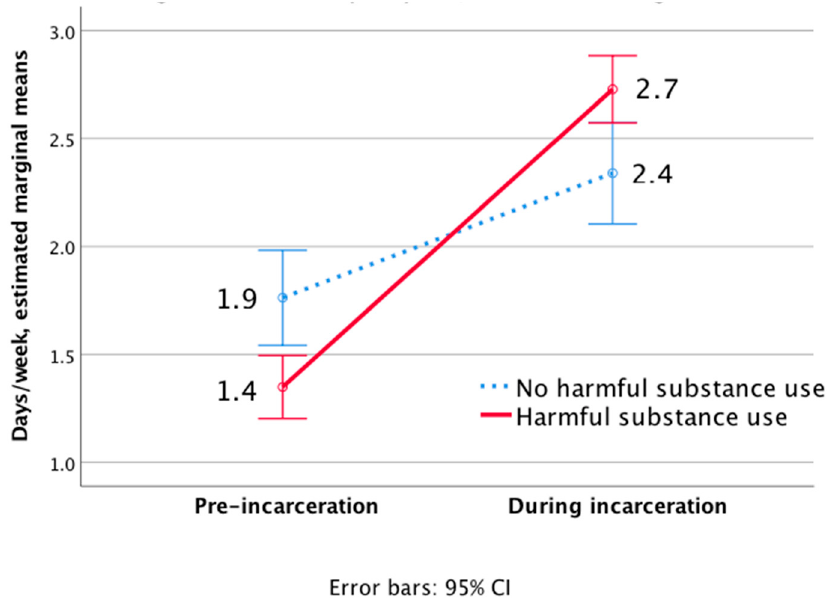
Figure 3. Changes in exercise frequency (sessions/week) of inmates during incarceration.